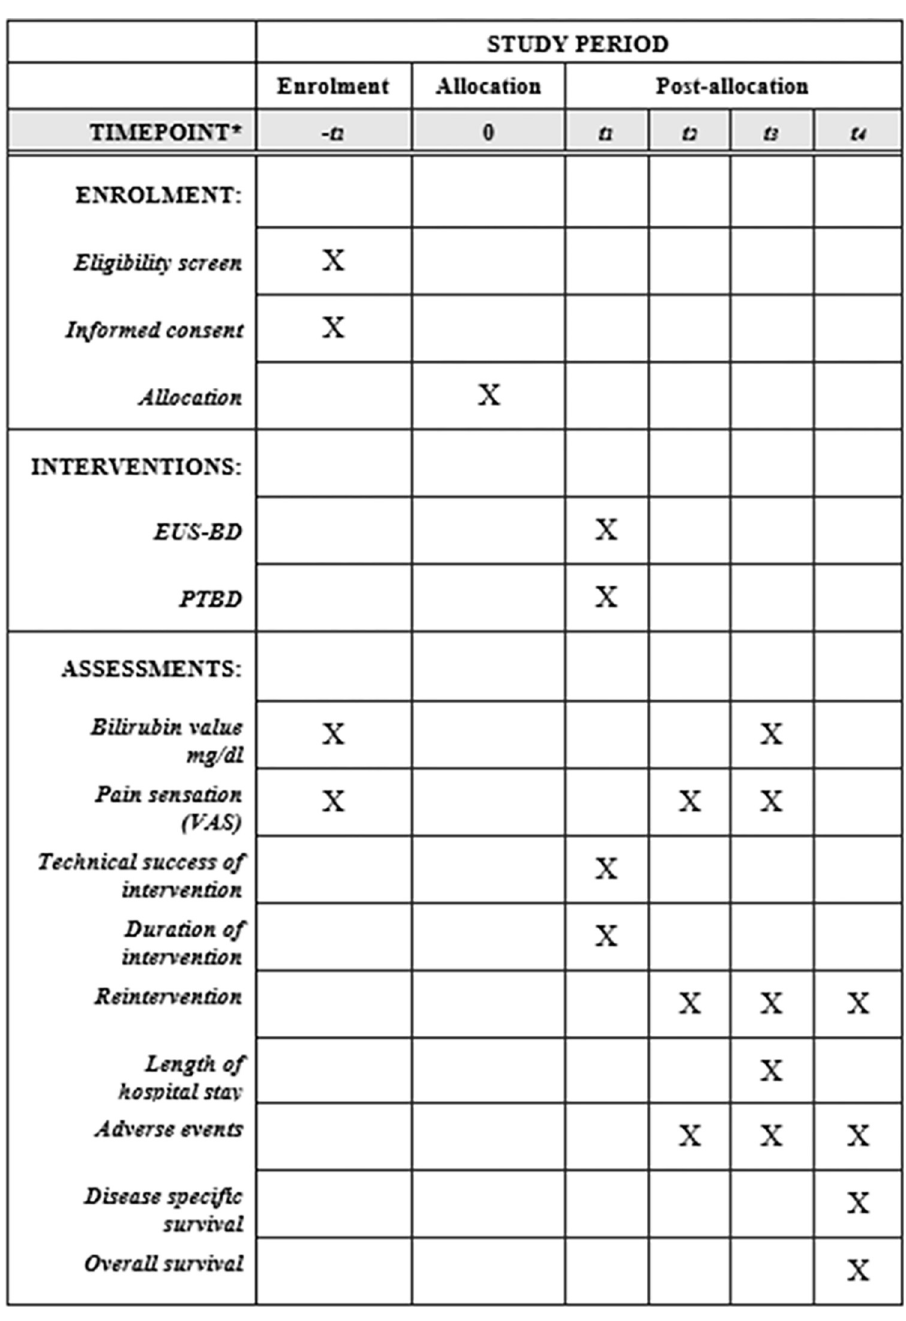
Fig 1. SPIRIT schedule. � List specific timepoints in this row: -t 1 = one day before intervention, t 1 = day after intervention, t 2 = one day after intervention, t 3 = 7 days after intervention, t 4 = 6 months after intervention.